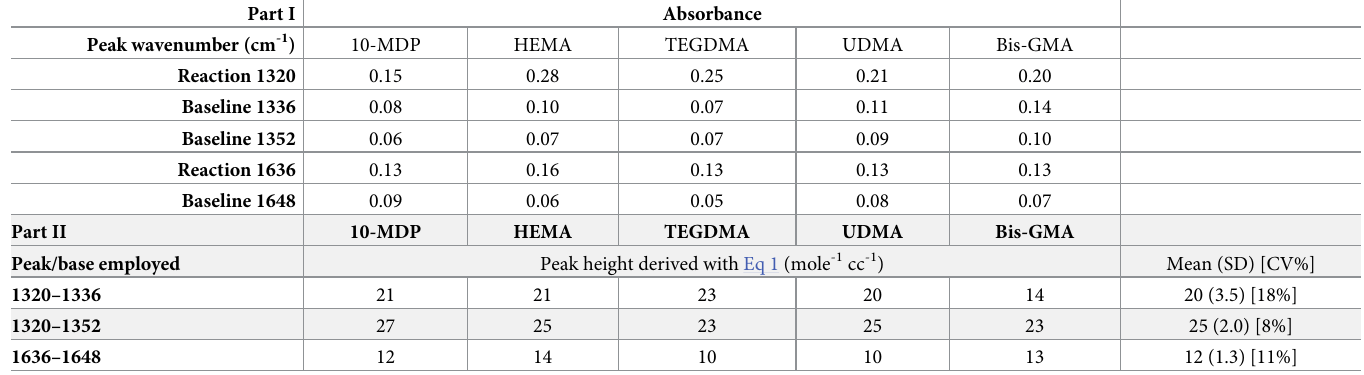
Table 2. Peak absorbance of individual monomers (Part I), from the spectra acquired and peak height per mole per cc, derived using Eq (1) (Part II), for the differ- ent reaction peaks and peak bases. Part I